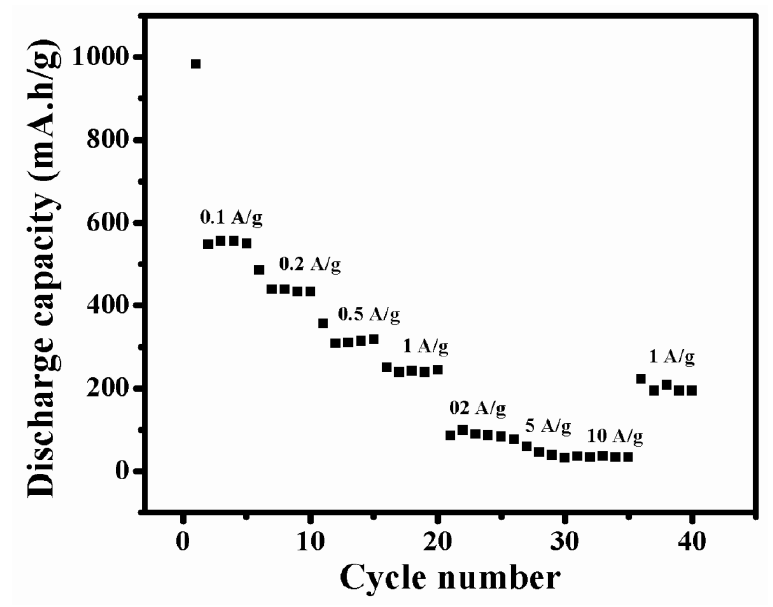
Figure 8. Rate performance of NMO.